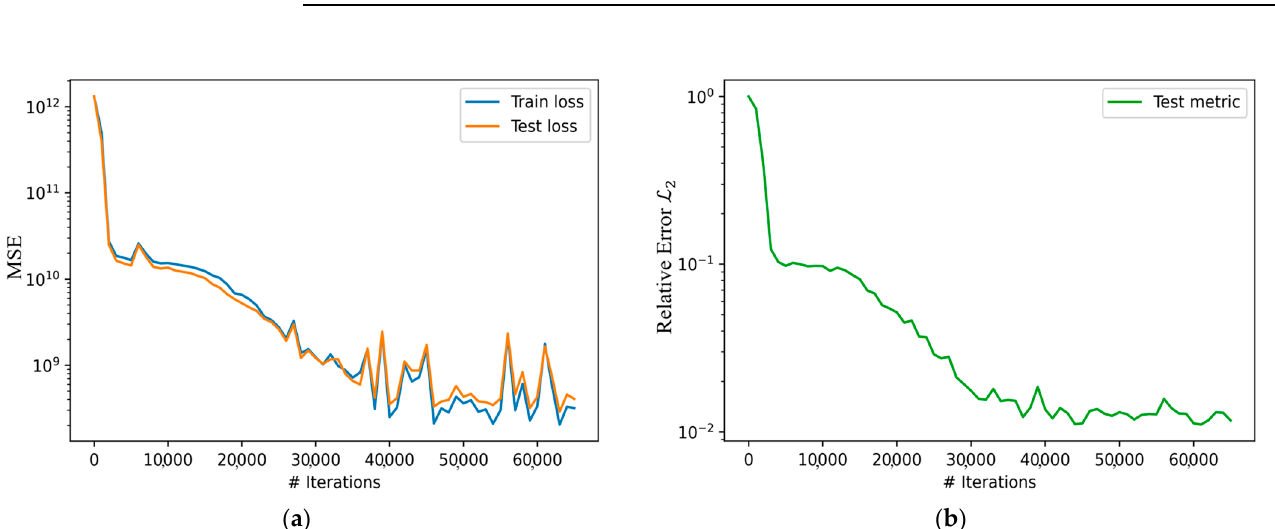
Figure 7. History of the loss function of PINN after 65,000 iterations for interpolation. ( a ) The training (blue) and testing (orange) loss is the summed-up MSE loss of all terms in the PKEs. ( b ) The test metric is the relative L 2 error for the first ODE